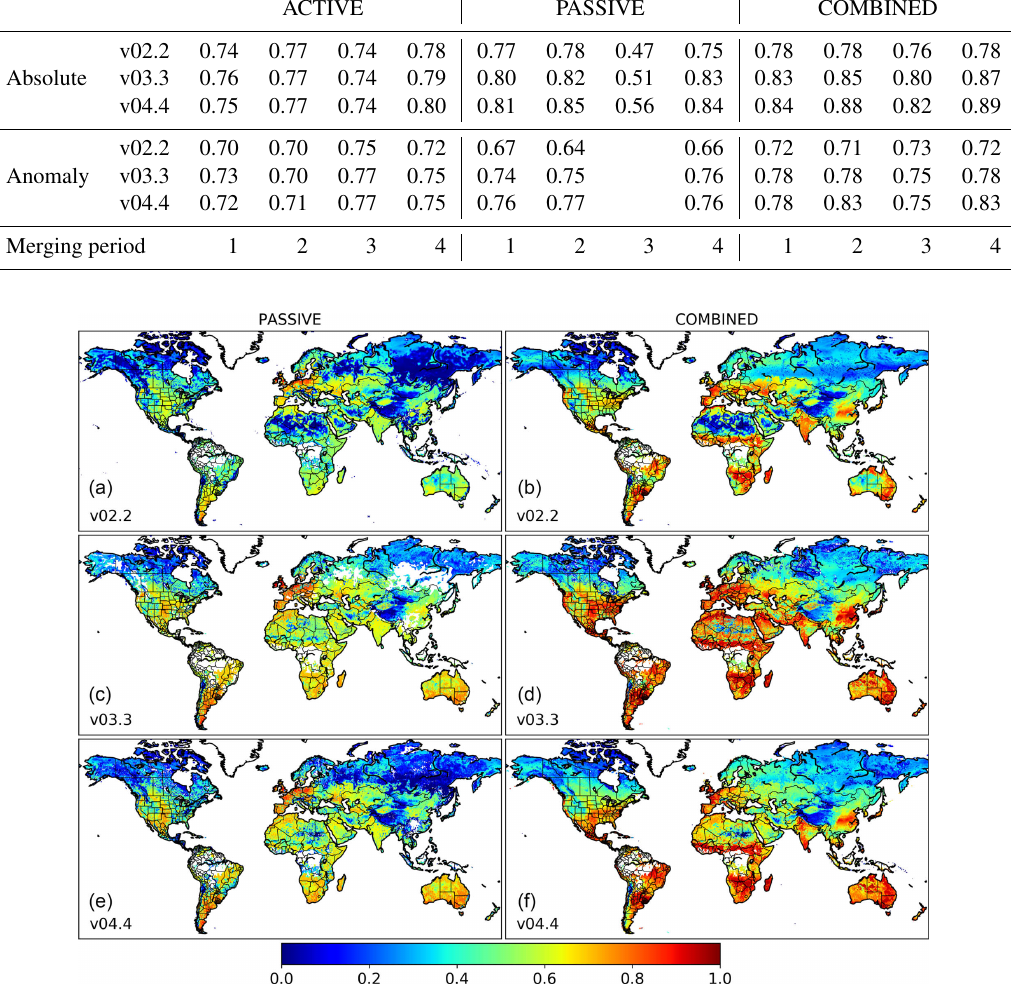
Figure 10. Fraction of days during the latest four merging periods (October 2007 to December 2014), where the PASSIVE (a, c, e) and COMBINED (b, d, f) product versions v02.2 (a, b) , v03.3 (c, d) and v04.4 (e, f) provide valid